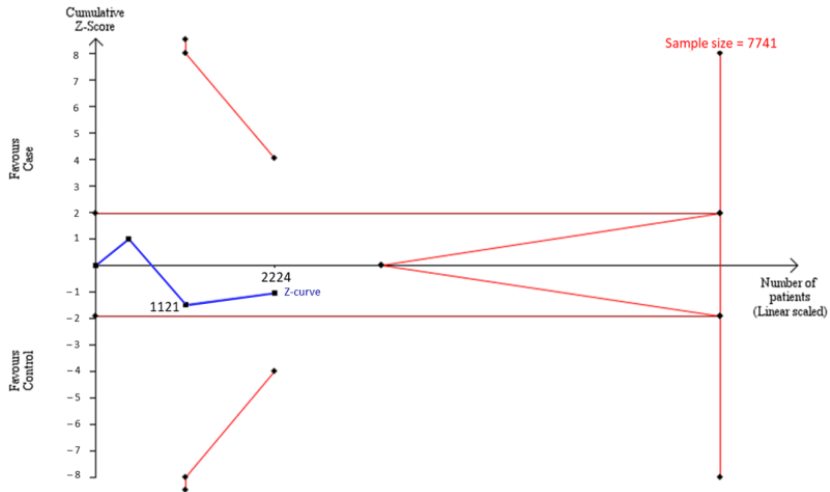
Figure 3. Trial Sequential Analysis (TSA) in Asians. We performed a TSA using an allele model assumption but replaced the allele count with the sample size (divided by 2). Detailed settings: Significance level = 0.05; Power = 0.8; ratio of controls to cases = 1; hypothetical proportion of controls with 2G allele = 0.47; least extreme OR to be detected = 1.3; I 2 (heterogeneity) = 88%.